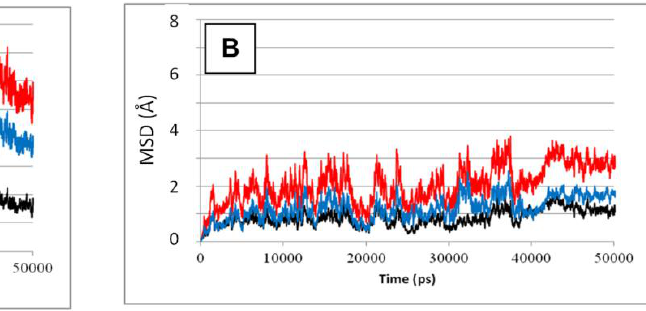
Figure 2. Structural stability of the SBD . The relative contribution of the different domains to the Mean Square Deviations (MSD) of the entire protein in: ( A ) SBD NR+ simulations; ( B ) SBD NR− simulations. The MSD of the full structure is shown in red, while the β-subdomain and the lid are colored in black and blue,